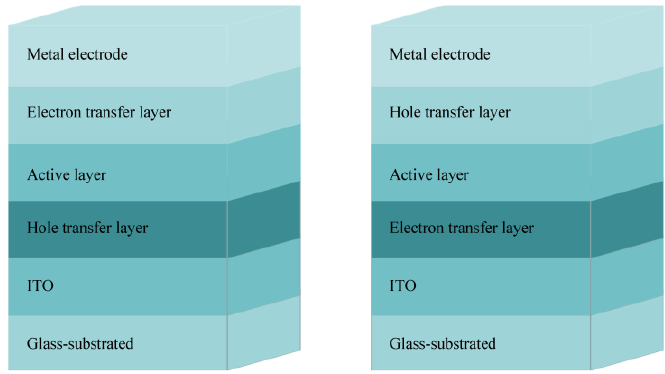
Figure 1. Schematic diagram of organic solar cell structure.